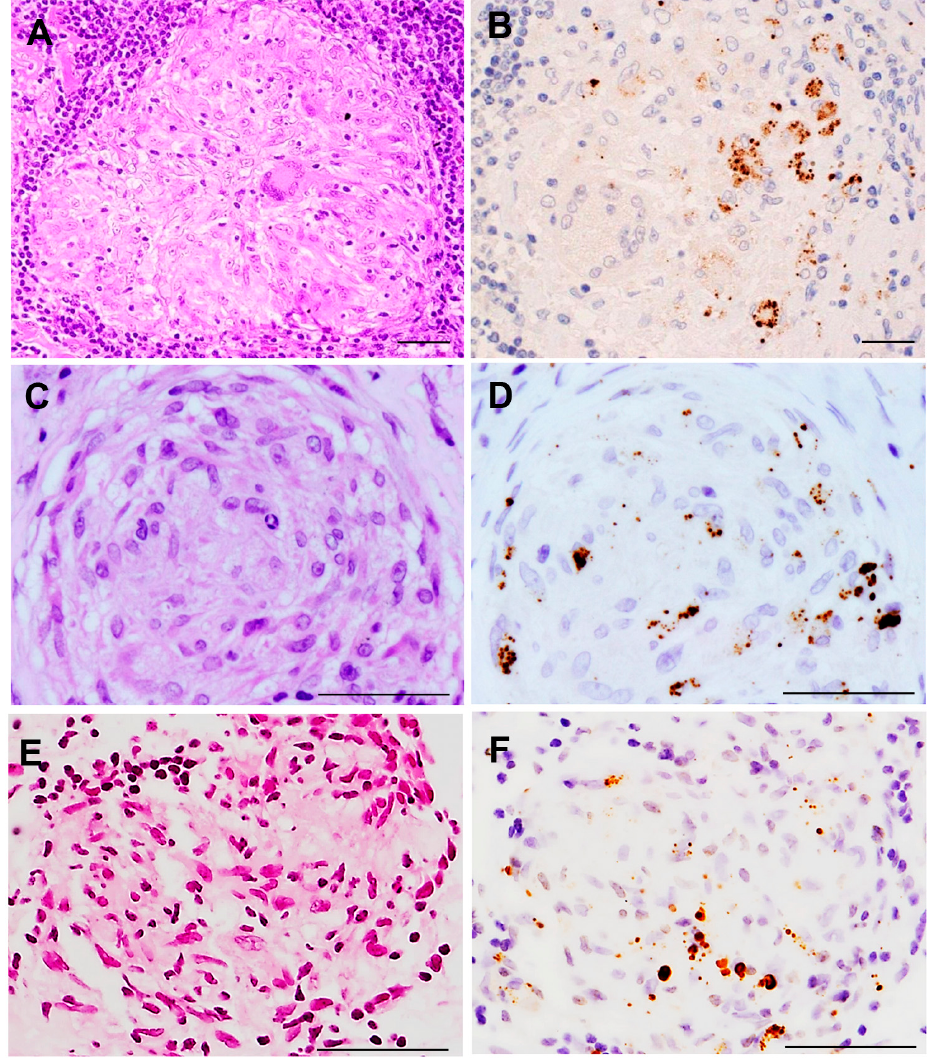
Figure 2. P. acnes in sarcoid granulomas detected by immunohistochemistry with PAB antibody. Hematoxylin–eosin stain and immunohistochemistry with P. acnes -specific PAB antibody are shown pairwise. PAB-reactive P. acnes (resulting in brown color) are observed in non-caseating epithelioid cell granulomas of the lymph node ( A , B ), lung ( C , D ), and ocular epiretinal membrane ( E , F ) from patients with sarcoidosis. Mainly small round and occasionally large ovoid positive-signals are observed in granuloma cells, irrespective of the sites at which the granuloma formed. All photos are original. Scale bar: 50 μ m.